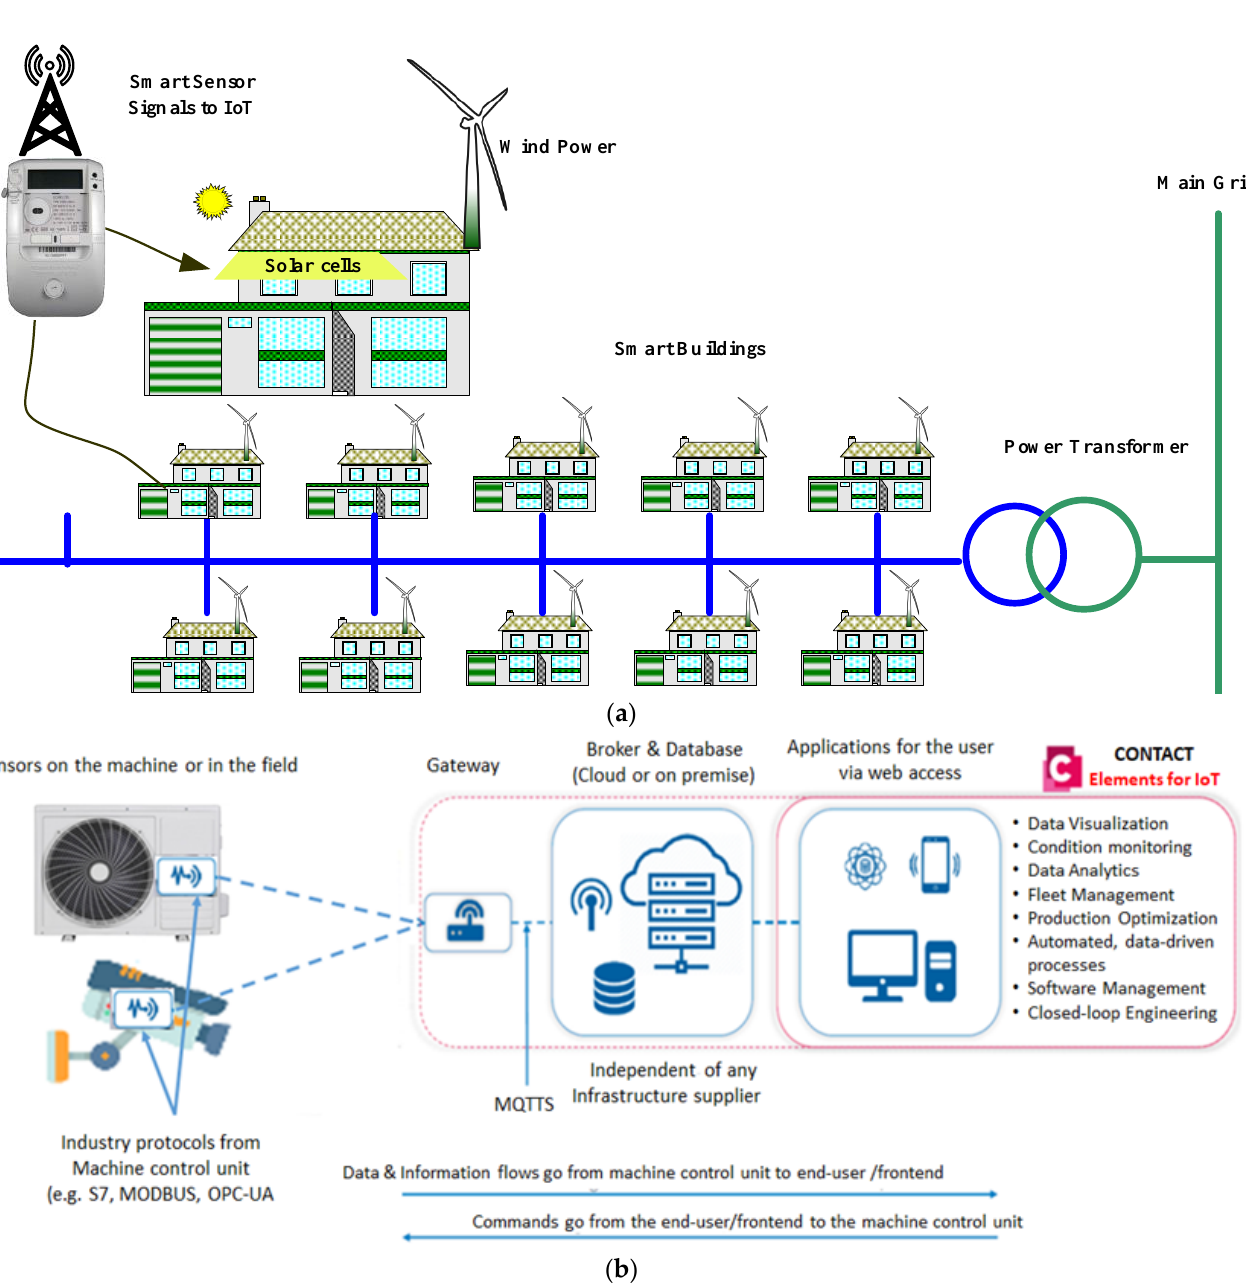
Figure 1. System diagram of the IoT based architecture: ( a ) smart buildings in electrical power systems, ( b ) air conditioner control unit connected to the IoT platform.